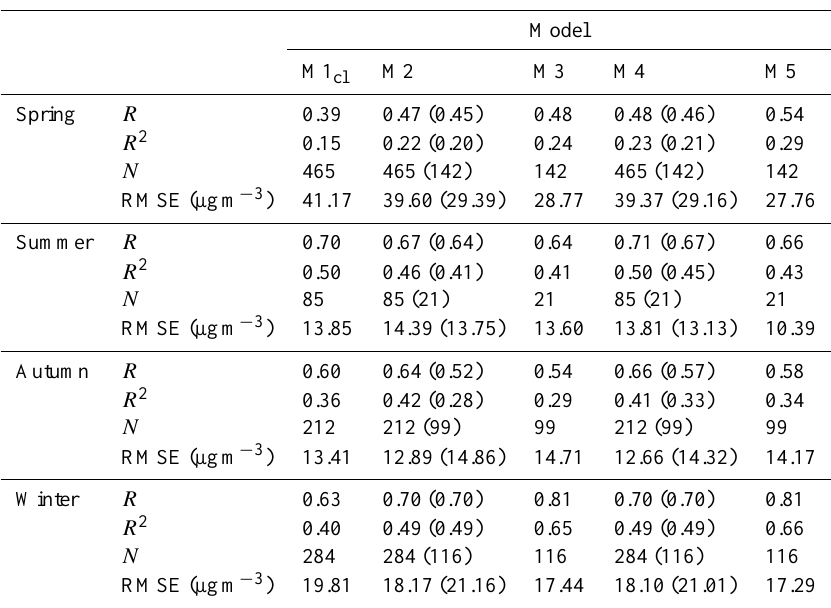
Table 7. Seasonal variations of the correlation coefficient ( R ) and root mean square error (RMSE) between measured PM 10 concentrations and those estimated by the different empirical linear models using AERONET data sets, collected at Yonsei University for 17 months. Performance of empirical models to estimate hourly PM 10 using AERONET data sets with respect to model and